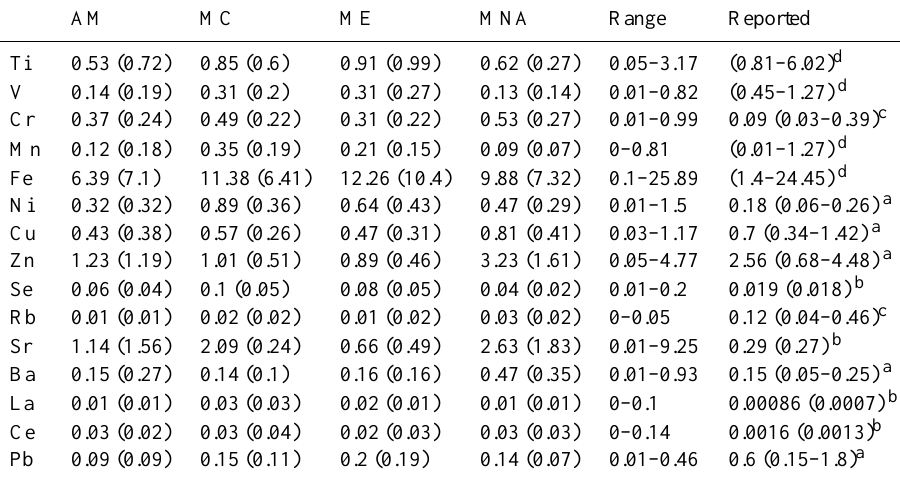
Table 3. Average (standard deviation), minimum, and maximum PM 10 trace metal concentration at CVAO under remote conditions for the various air mass origins. Samples with mixed scenarios were not considered in obtaining the average values. Values are given in ngm − 3 . Range shows the lowest and highest concentrations measured in all the samples irrespective of their air mass origin. Reported column represent mean concentrations and their reported ranges in